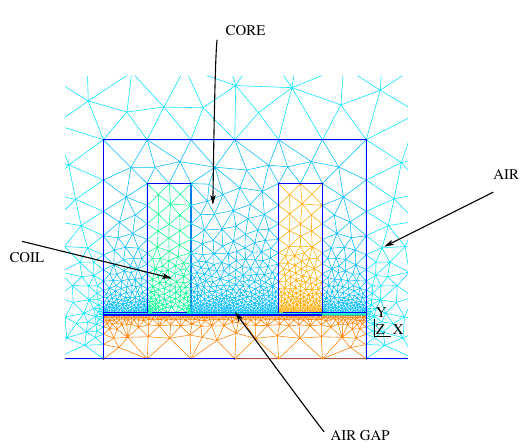
Figure 4: FE air-gapped inductor meshed geometry [16].